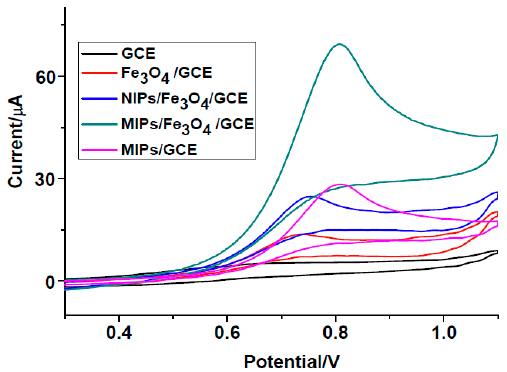
Figure 3. Cyclic voltammograms (CVs) of modified electrodes in 0.1 mol · L − 1 phosphate buffer solution (PBS) containing 50 µM of 2,4 ‐ DCP. Scan rate: 0.1 Vs − 1 .